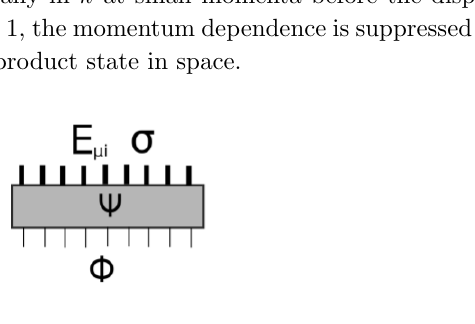
Figure 8 . A tensor representation of the wavefunction (cid:9)((cid:8); E; (cid:27) ), where the triad and a scalar (cid:12)eld are collective variables of the matter